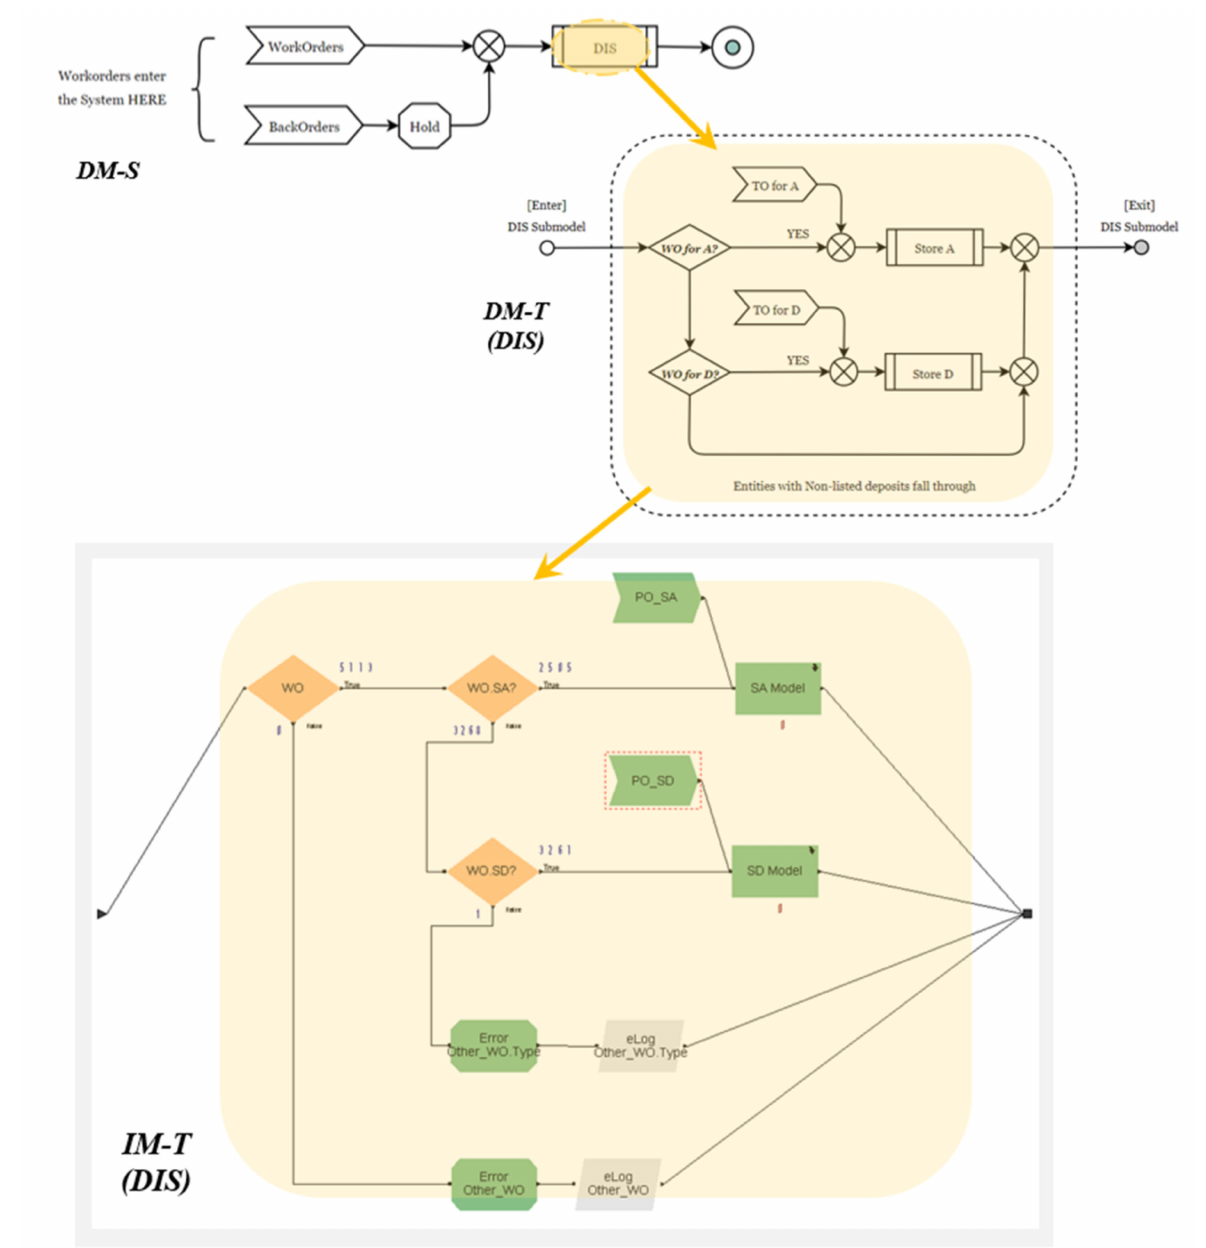
Figure 24. Conversion of DM-T into IM-T highlighted in beige. Top left is DM-S (detailed in Figure 20), from where top right DM-T comes from (detailed in Figure 21). The diagram shows the relationship between the sub-models. The details of the individual models are not relevant to the present discussion.